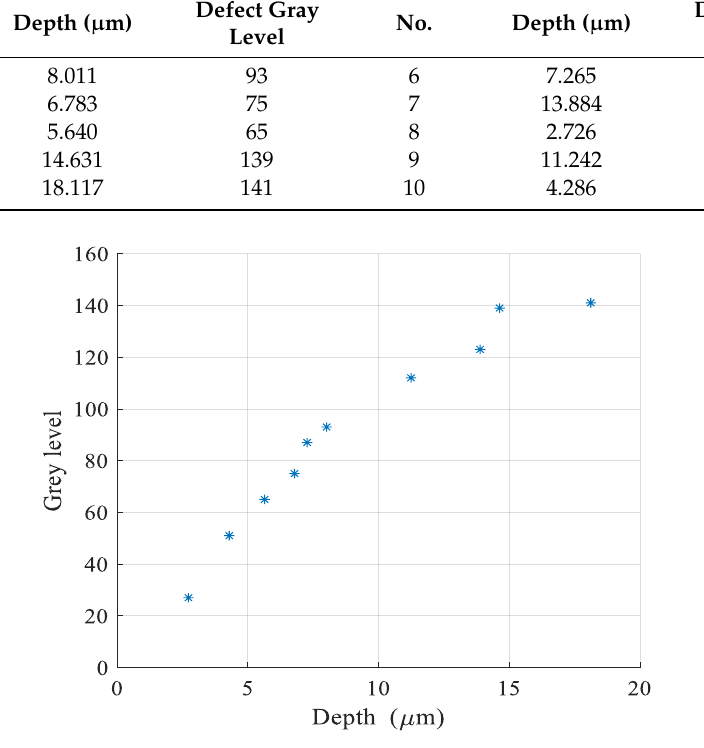
Figure 4. Saturated imaging grey level varies with defect depth.